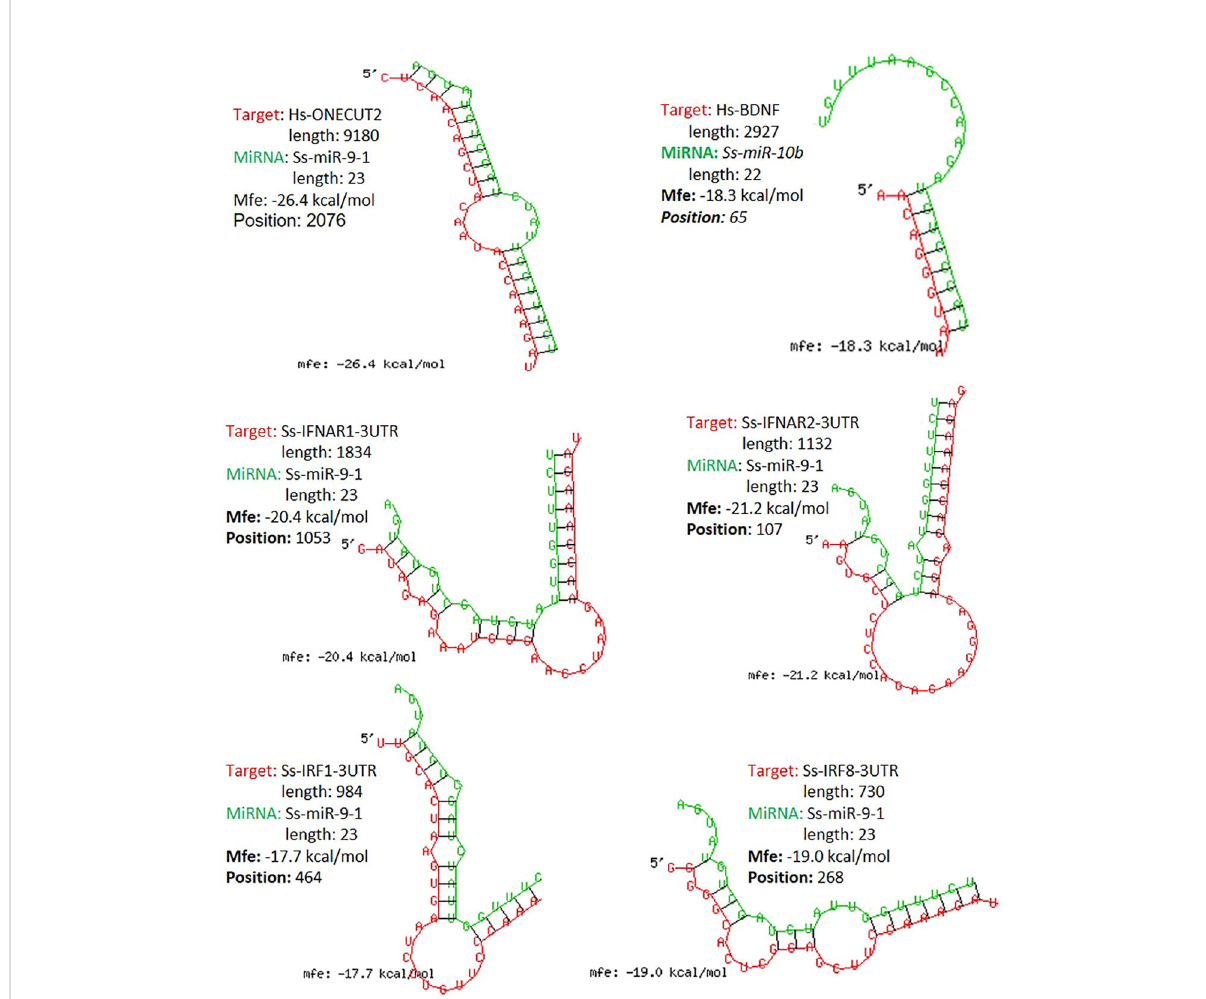
FIGURE 7 Graphic demonstration of hairpin structures of selected porcine miRNAs and targeted sites on the 3-UTRs of respective human (Hs) or porcine (Ss) transcripts. The selected two miR-9-1 and miR-10b are conserved in both humans and pigs and their targets and effect on human ONECUT2 and BDNF transcripts have been validated in referred studies. Hybridization of individual miRNA with its mRNA targets was performed using RNAhybrid with its accompanying programs RNAcalibrate and RNAeffective as described. No G:U pairing was allowed in the 1-7 seed residues of the 5 ’ -end of miRNAs. The hybridization structures and minimum free energy (Mfe) are given, the thresholds of Mfe was set as -28.0 kcal/mol to re fl ect the typical Mfe of miRNA (like let7 ) hybridization to mRNA targets. The GenBank Accession numbers of the tested transcripts and all other predicted miRNA-mRNA interactions are provided in the Supplement Excel